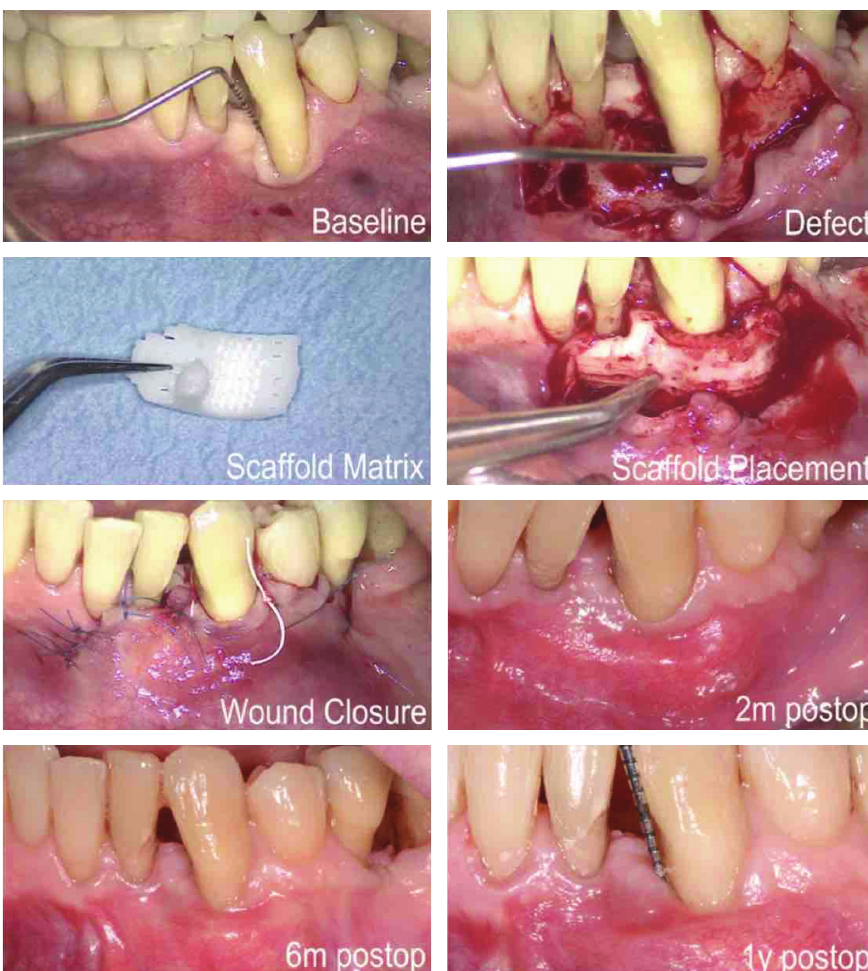
Figure 4: Custom-made 3D-printed PCL/HAp scaffold based on images from computed tomography (CT) scans and combined with CAD/CAM technologies for periodontal tissue regeneration. Courtesy of Rasperini et al., 2015